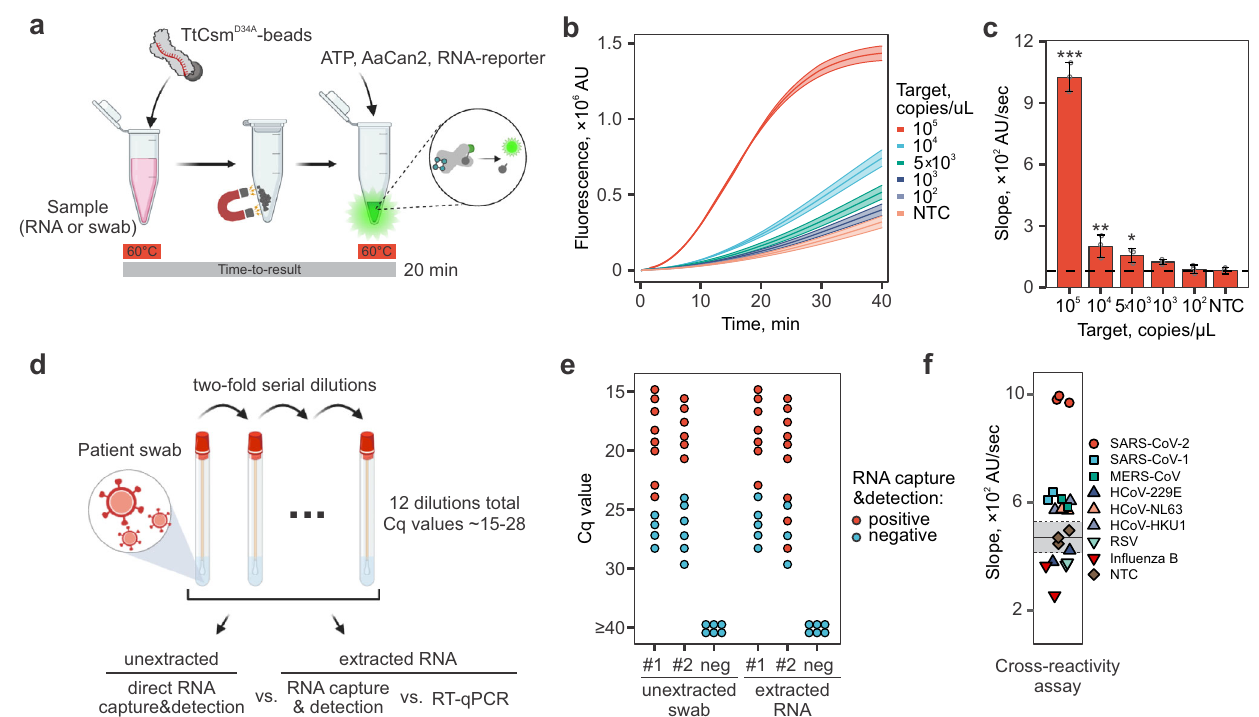
Fig. 5 | TtCsm-based RNA capture directly detects SARS-CoV-2 in clinical sam- ples.a Schematicof TtCsm-basedRNAcaptureassayfrompatientsamplecoupled with AaCan2-based fl uorescent detection. Two-step protocol includes incubation of TtCsm-beads with RNA sample at 60°C followed by concentration of the mag- neticbeads,andadditionofabuffercontainingATP,AaCan2anda fl uorescentRNA reporter (i.e., FAM-RNA-Iowa Black FQ). b RNA detection assay asshown in ( a ) was performed using samples with target RNA concentrations ranging from 10 7 to 10 2 copies/ µ L.Samples wereprepared byspiking IVTfragments of SARS-CoV-2 N gene intointotalhumanRNA(HEK293Tcells).Cleavageof fl uorescentRNAreporterwas detectedby measuring fl uorescenceevery 10s in a real-time PCR instrument (left). Data were plotted as mean of three replicates ± S.D. (ribbon). c Simple linear regression was used to calculate slopes for linear regions of the curves. Bars show meanvalues( n =3)±S.D.(right).Datawasanalyzedwithone-wayANOVAfollowed by multiple comparisons to NTC sample using one-tailed post-hoc Dunnett ’ s test. *** p <0.001; ** p <0.01; * p <0.05. d Patient samples (e.g., nasopharyngeal swabs)